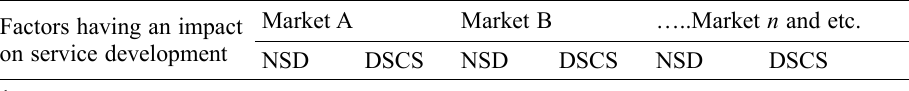
Table 1. Matrix for determining the influence of environmental factors on both directions of business development Market A Market B …..Market n and Factors having an impact on service development